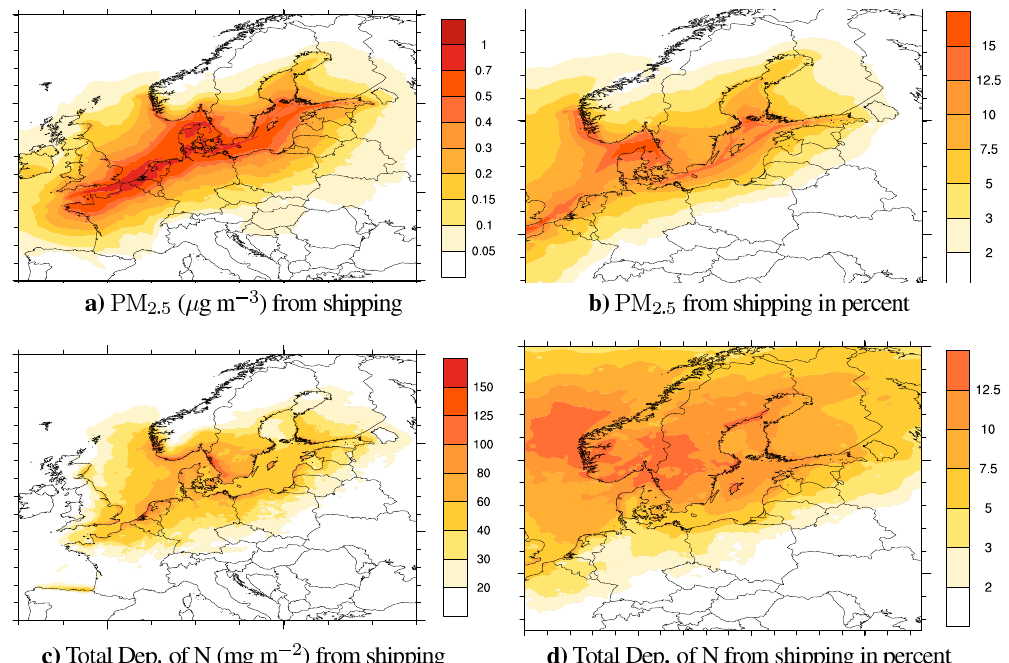
Figure 4. Contributions from year 2009 ship emissions in the Baltic Sea and the North Sea to PM 2 . 5 concentrations (a) and in percent (b) . Contributions to the total deposition of nitrogen in mgm − 2 (c) and in percent (d)